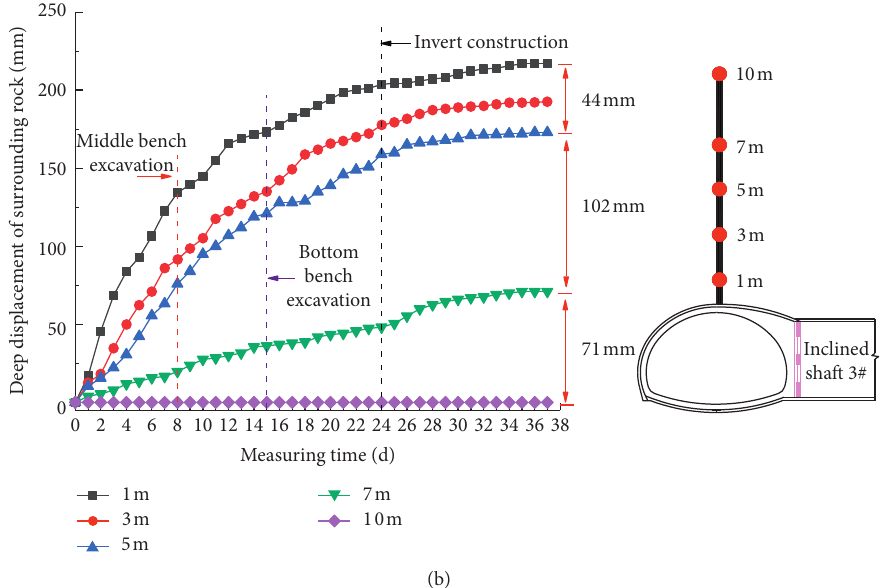
Figure 21: Deep displacement of surrounding rock. (a) Deep displacement of inclined shaft 2# intersection. (b) Deep displacement of inclined shaft 3# intersection.